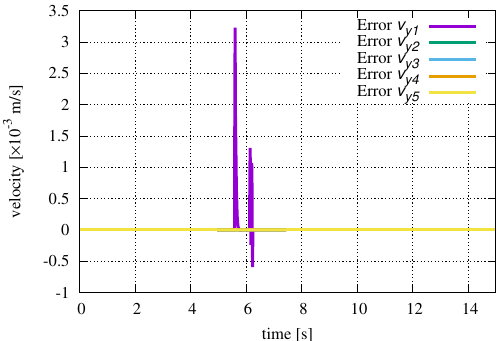
Figure 14. Case 1: Time variation of estimation error of the velocities in the axial direction.